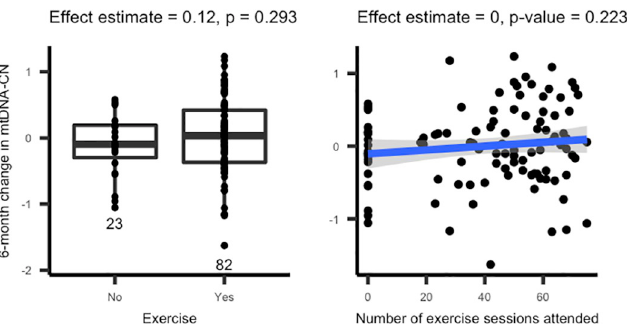
Fig 3. 6-month change in mtDNA-CN was not associated with exercise. There was no significant association between exercise intervention and 6-month change in